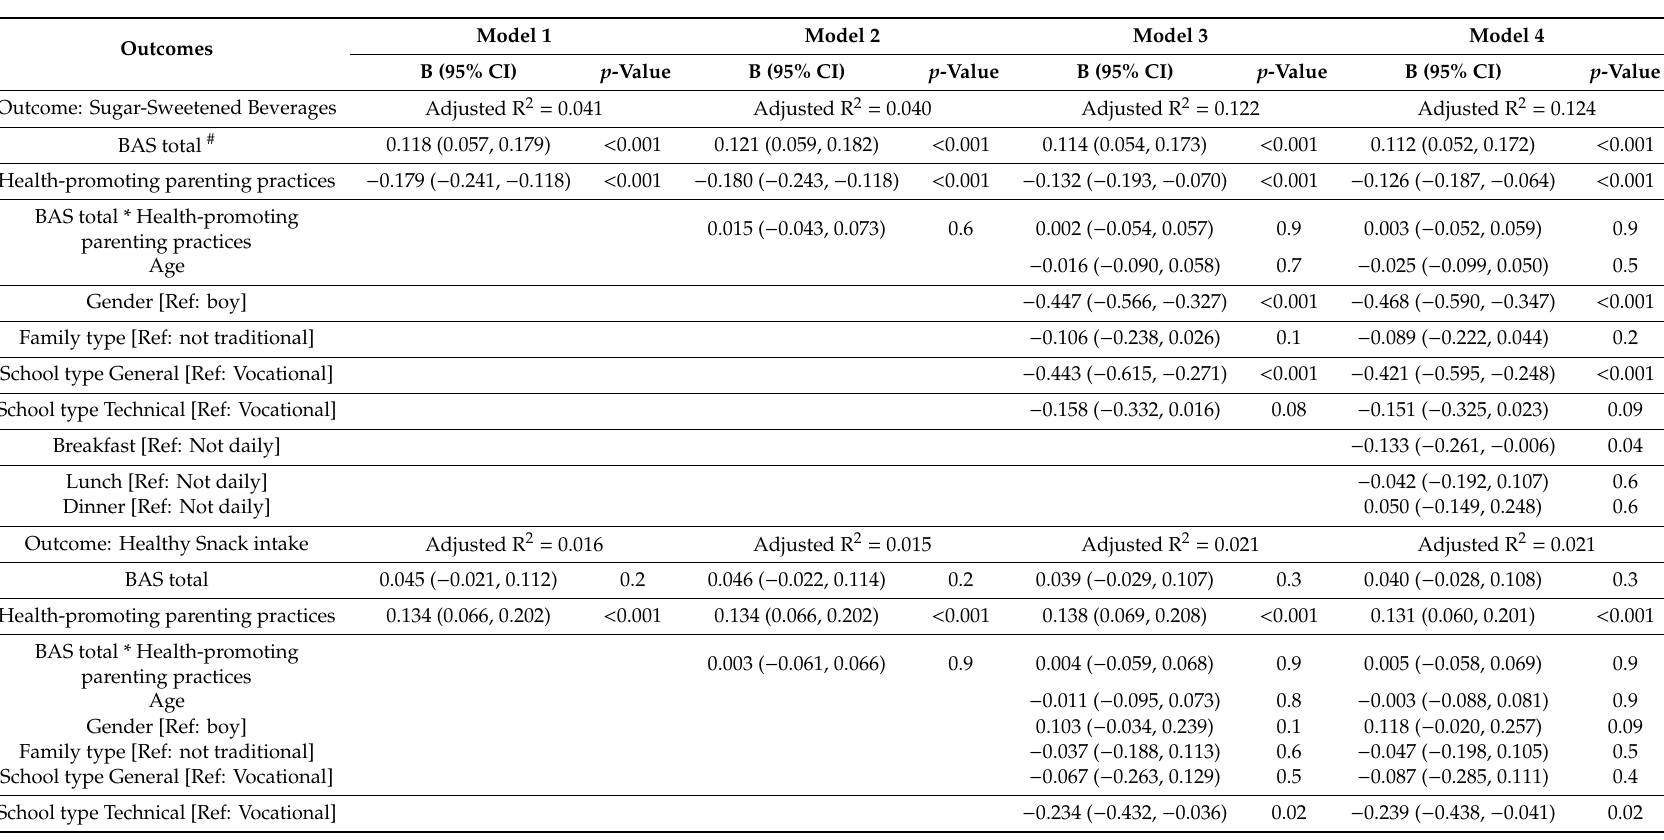
Table A1. Associations between reward sensitivity and adolescents’ intake of sugar-sweetened beverages, healthy and unhealthy snacks, and the moderating role of (adolescent-reported) health-promoting parenting practices for all cases ( n = 1104). Model 1 Model 2 Model 3 Model 4 Outcomes B (95%